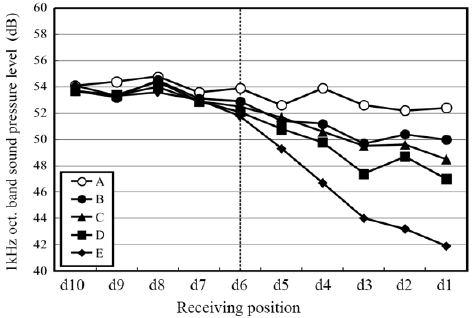
Figure 16. Results of the A-weighted sound pressure level on line “d” on each absorption pattern. The dotted line represents the boundary of the front room and evaluation space.